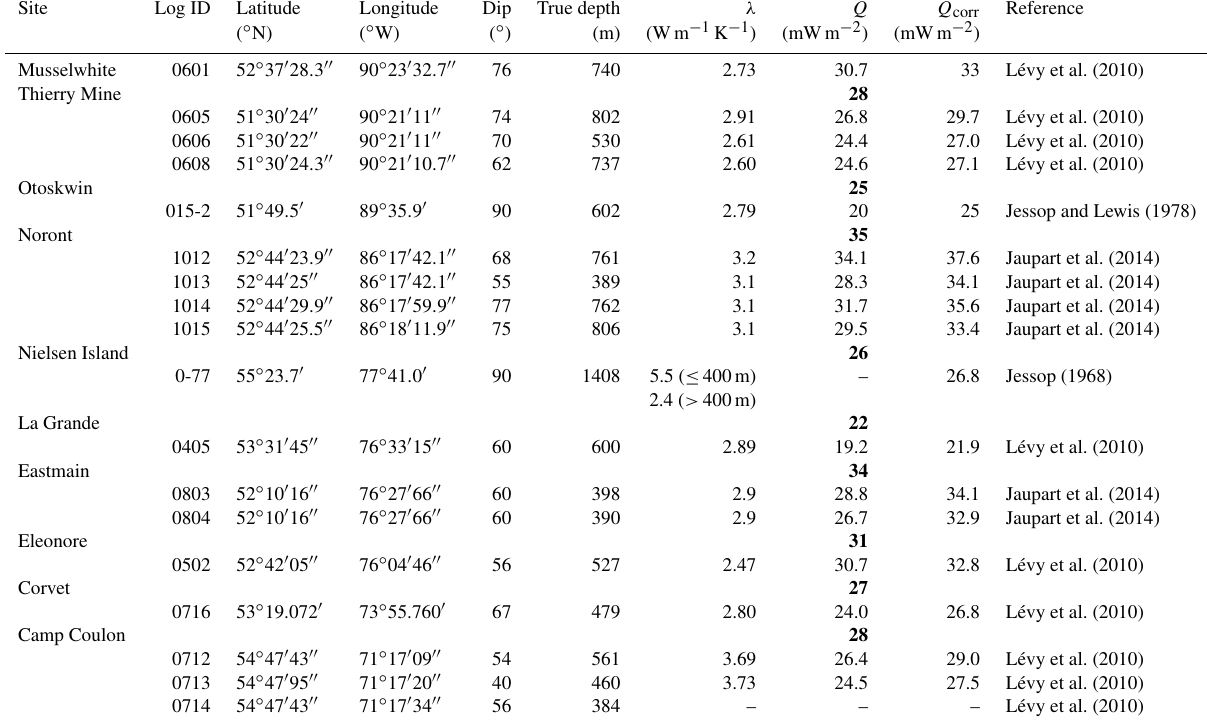
Table 1. Location and technical information concerning the boreholes used in this study, where rue depth is the depth corrected for the dip of the borehole, λ is the thermal conductivity, Q is the heat flux, and Q corr is the heat flux corrected for post-glacial warming. The heat flux for the site is represented by the bold values. The heat flux for each individual hole is in roman. Site Log ID